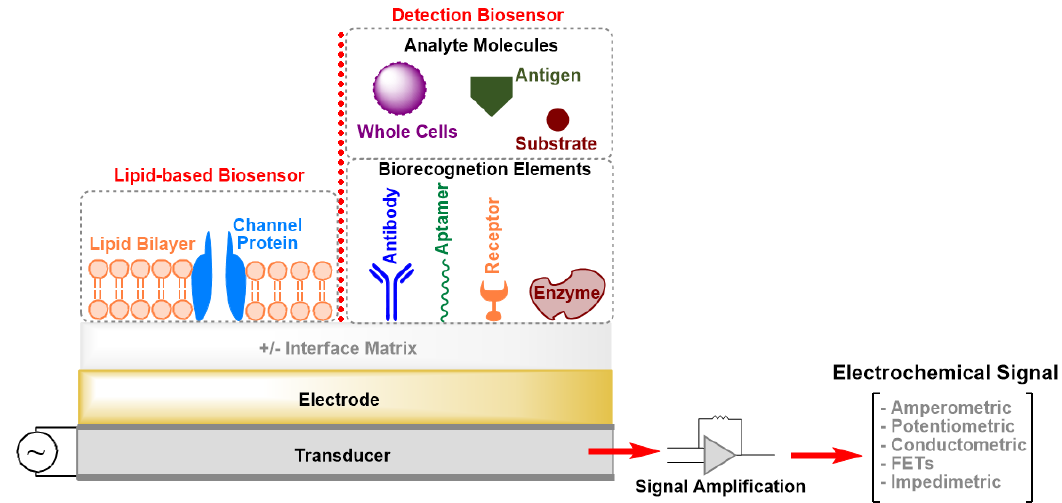
Figure 1. Schematic drawing (not drawn to scale) of the elements of an electrochemical biosensor. FETs: Field-Effect Transistors.